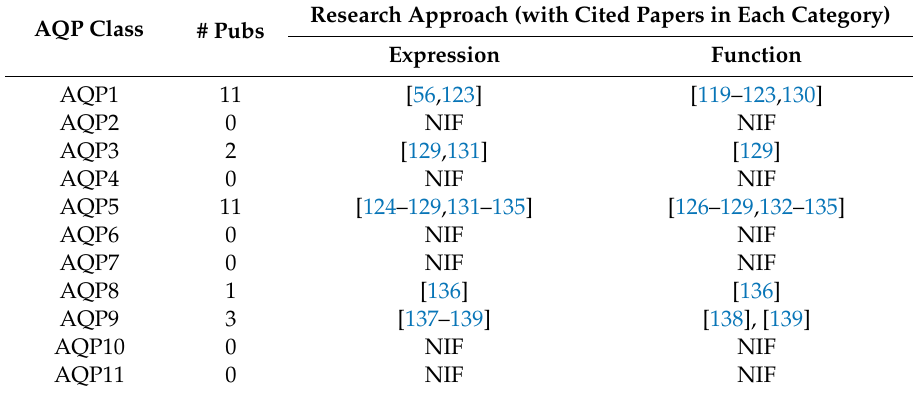
Table 3. Publications on AQPs in colon cancers, classified by research approach. Research Approach (with Cited Papers in Each Category) AQP Class # Pubs